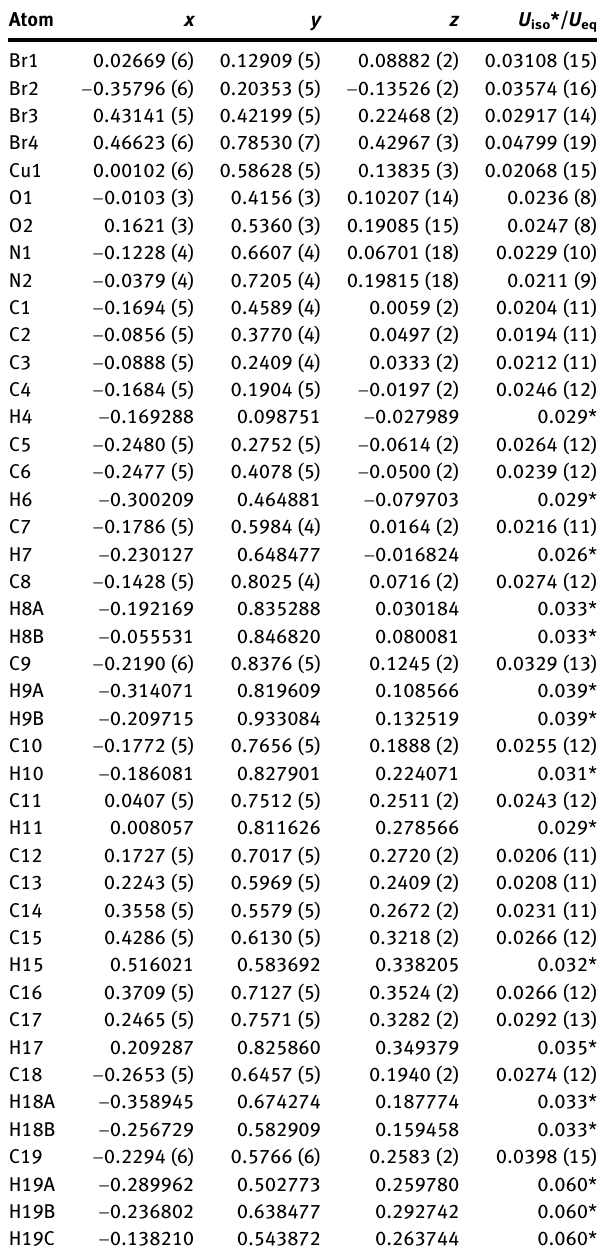
Table  : Fractional atomic coordinates and isoropic or equivalent isotropic displacement parameters (Å 